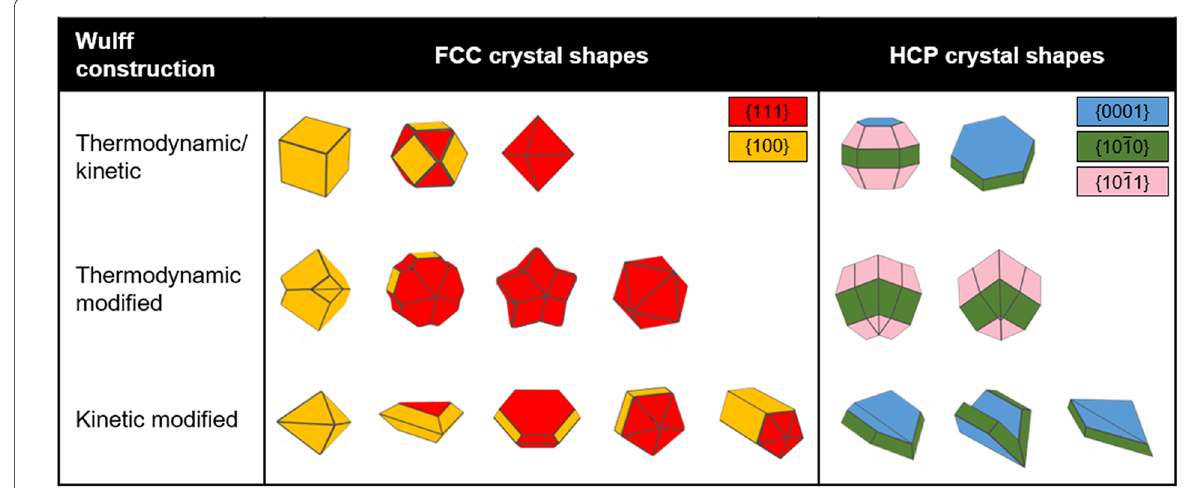
Fig. 3 Nanocrystal shapes in the single crystal thermodynamic/kinetic, thermodynamic modified and kinetic modified Wulff constructions for FCC and HCP crystal structures. The FCC structures are twinned along the (111) plane, while the twinning plane varies for HCP as described in ref. [31] Facets are colour coded according to legend and shapes were created in Crystal Creator